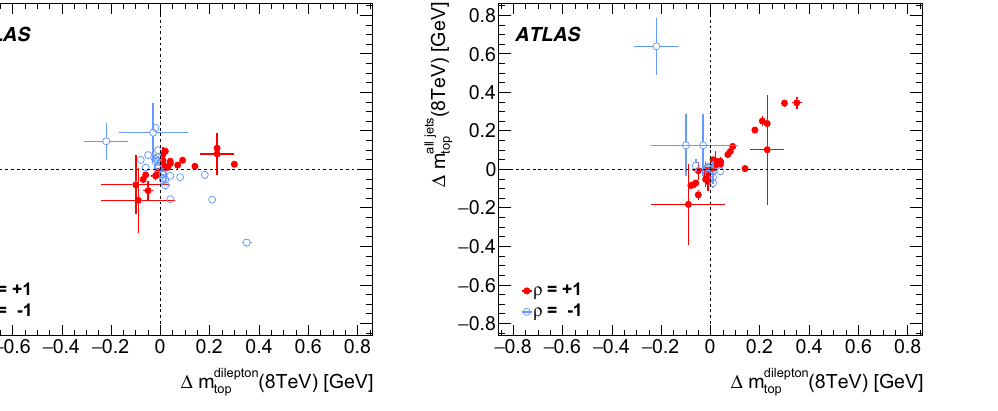
(b) t ¯ t → dilepton (8 TeV) and t ¯ t → alljets (8 TeV)